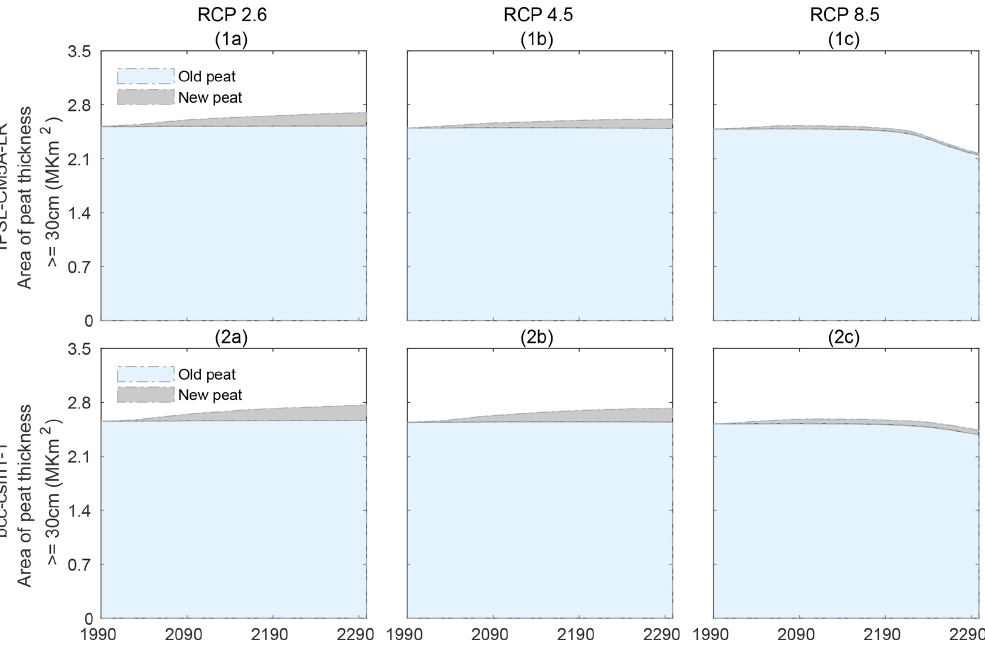
Figure 5. Time series of pan-Arctic old and new peatland area (10 6 km 2 ) during